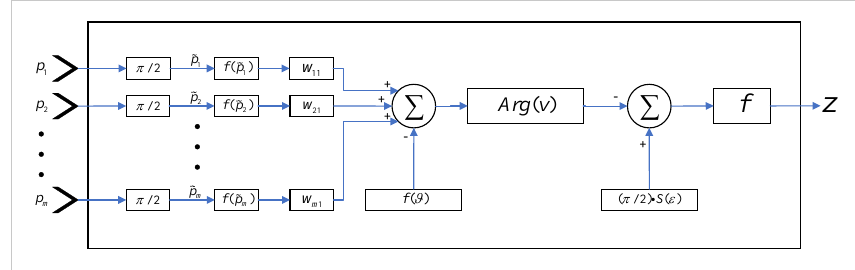
Figure 1. The general structure of the qubit neuron